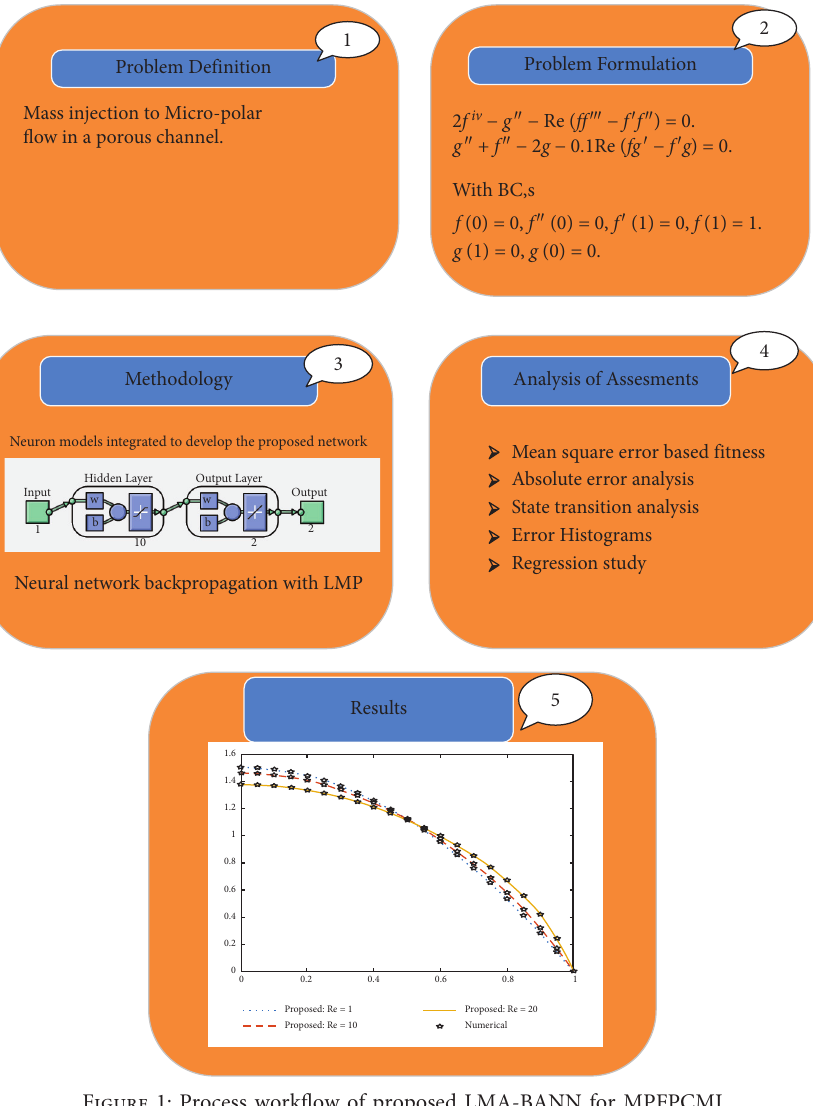
Figure 1: Process workflow of proposed LMA-BANN for MPFPCMI.